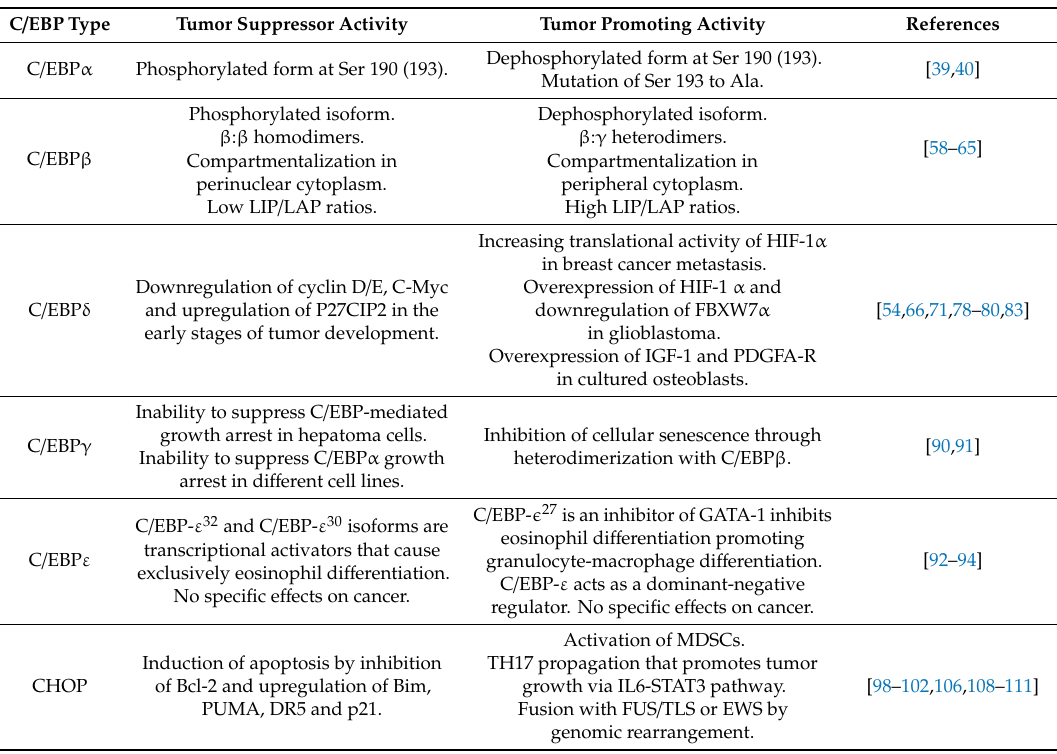
Table 2. Molecular mechanisms of tumor suppressor and the tumor promoting activity of each C / EBP family